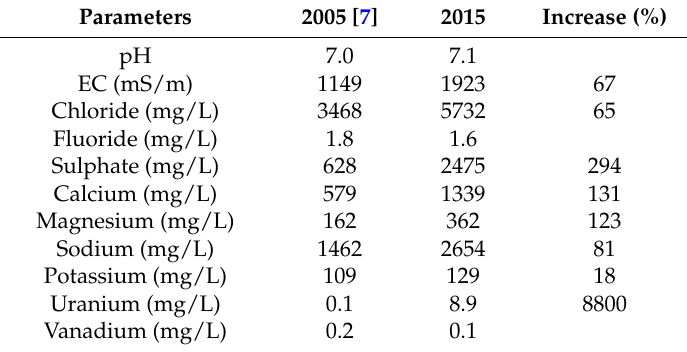
Table 3. The change in the water quality over the ten year period of the borehole LHU-1049. The 2005 chemical data were reproduced with permission from the SEMP office, GSN-Ministry of Mines and Energy, Windhoek, Namibia.